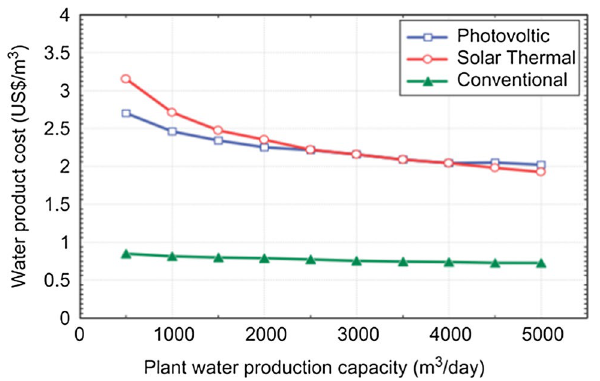
Fig. 19 Water product cost per water production capacity for consid- ered methods (Shatat et al. 2013)